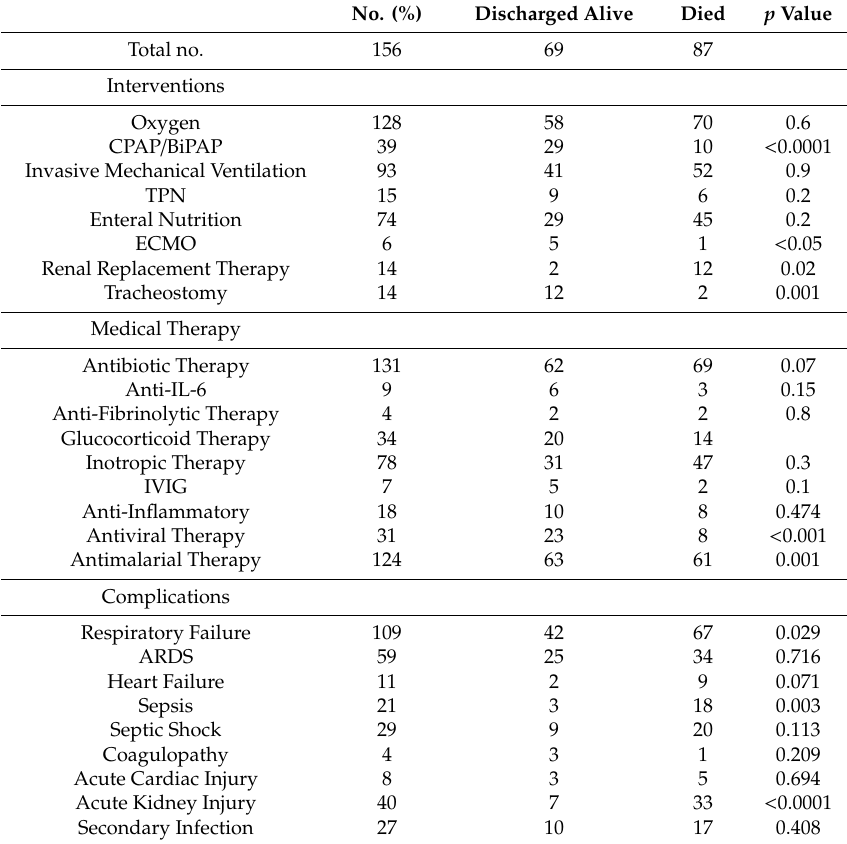
Table 3. Summary of clinical measures and complications in critically ill Covid-19 patients treated in the ICU at study end